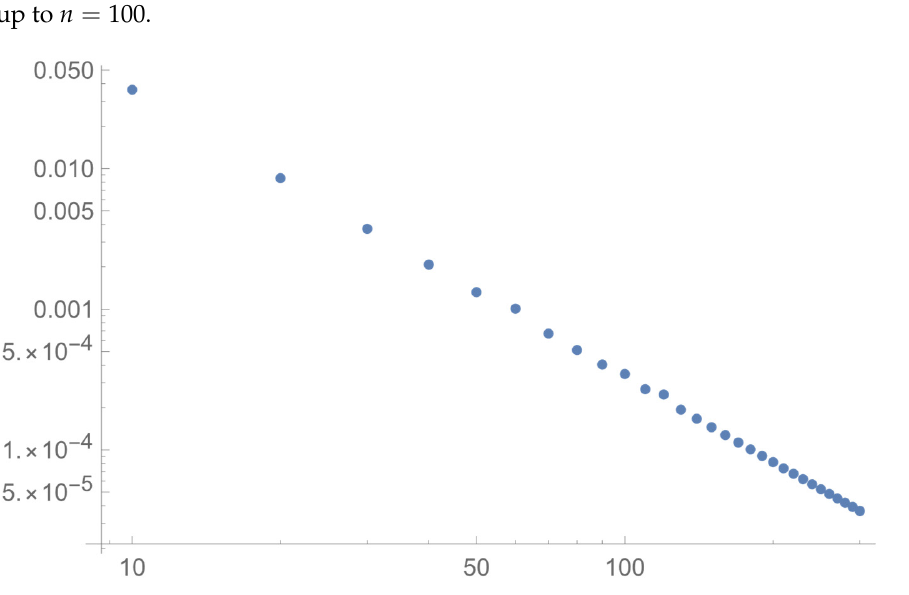
Figure 4. Difference between the area 𝐴(𝑛) of the optimized polygon and 𝜋 4⁄ , for selected even values 4 ≤ 𝑛 ≤ 150.